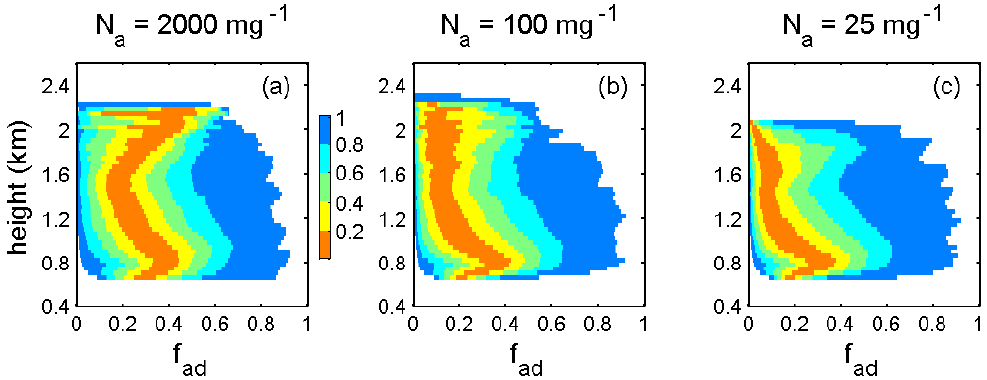
Fig. 5. Averaged profiles of adiabatic fraction ( f ad ) over the last 4h of simulation for the three cases. Color scale is the same as Fig. 1.